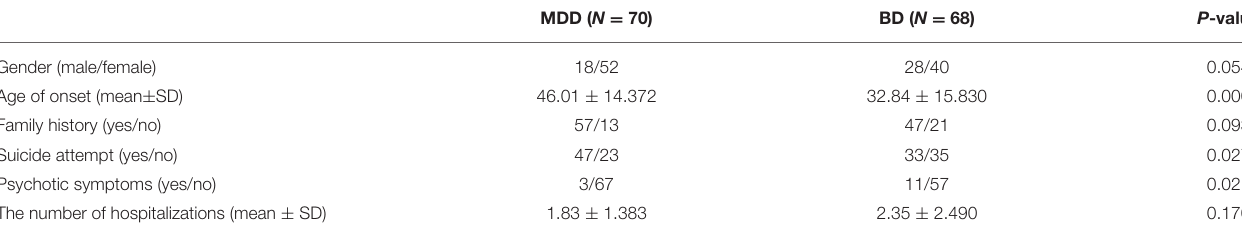
TABLE 1 | General characteristics of patients with MDD and BD.